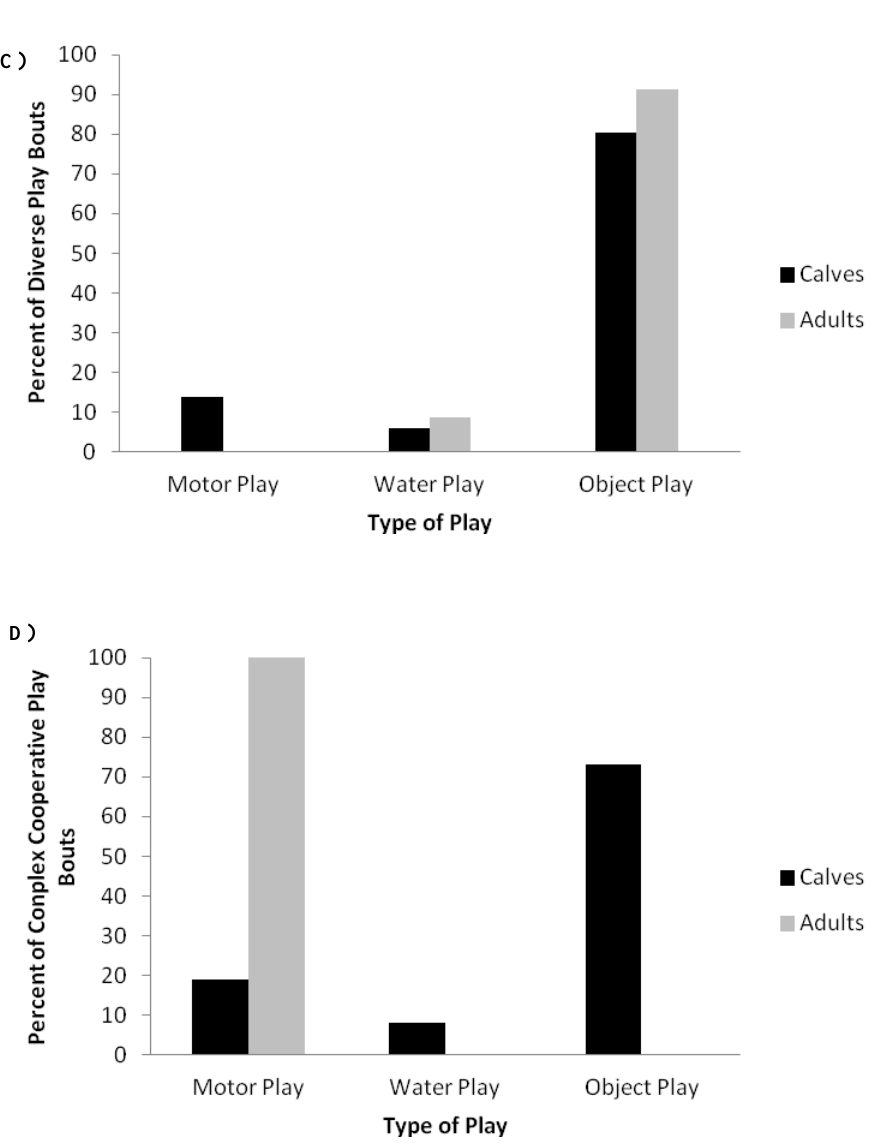
Figure 4. Percent of type of play per age for each complexity of play category. A) Breakdown of percent of type of play for mature and immature belugas displaying single event bouts. B) Breakdown of percent of type of play for mature and immature belugas displaying diverse play bouts. C) Breakdown of percent of type of play for mature and immature belugas displaying repetitive play bouts. D) Breakdown of percent of type of play for mature and immature belugas displaying complex cooperative/social play